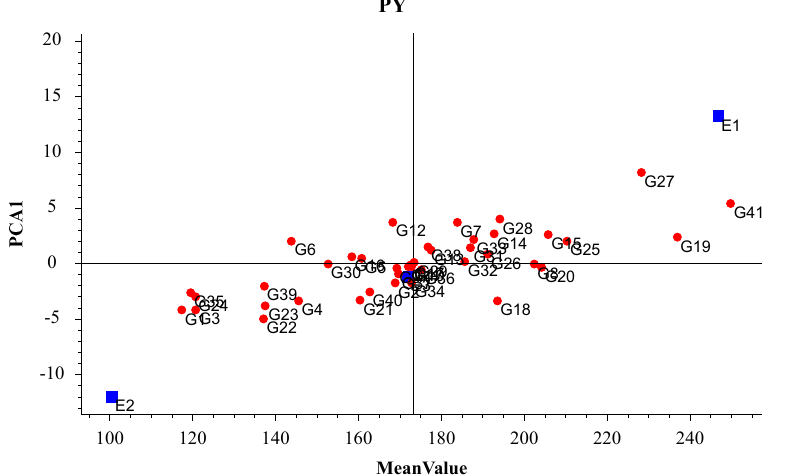
Figure 2. AMMI biplot (PCA1: average yield). E1, E2, and E3 represent spring, summer, and autumn, respectively. G1–38 represents BJ1–38; G39 represents ZJ–1; and G40 and G41 represent GX18–11 and GX18–21, respectively.